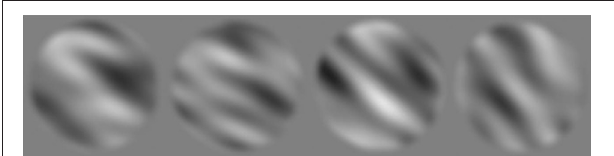
FIGURE 1 | Fractal rotation stimulus example. Stimulus is rotating clockwise. From this 4-frames sequence, it can be seen that a noise frame is resampled at every frame. An example movie of these stimuli can be viewed in Lagacé-Nadon et al. (2009; Movie